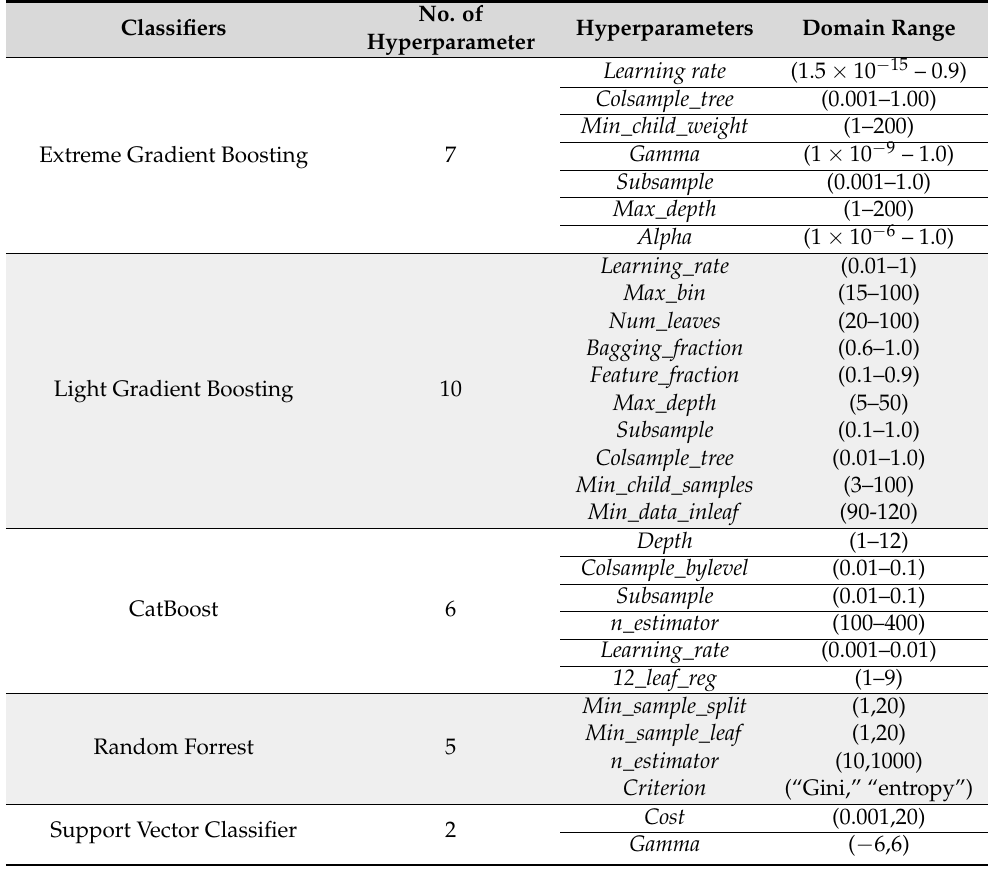
Table 2. Tune Hyperparameters and their domain range.